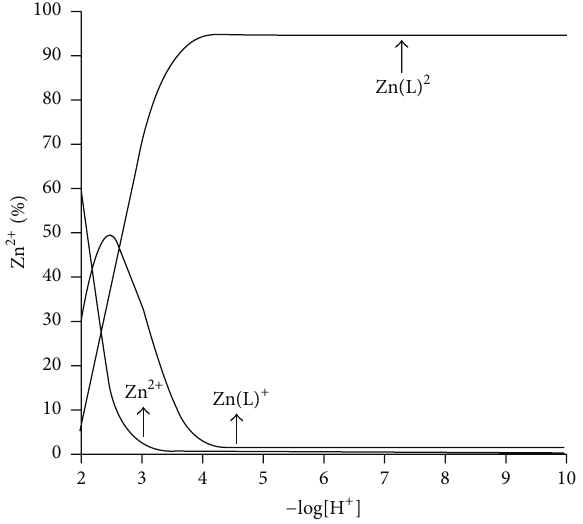
Figure 5: Potentiometric titration studies of zinc-diosmin complex.